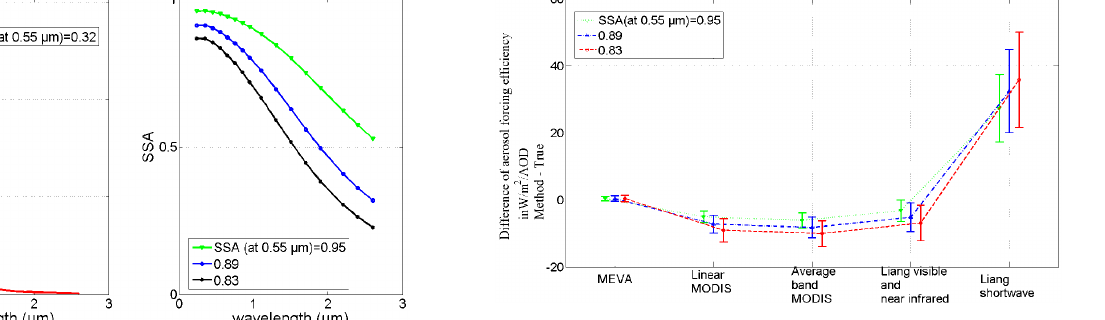
Fig. 10. The plot on the left shows the wavelength dependence of AOD for the aerosol models used in the TOA flux and aerosol forc- ing calculations; the plots on the right display three different aerosol models used in the flux and aerosol forcing calculations: SSA (at 0.55µm)=0.95, 0.89, and 0.83.